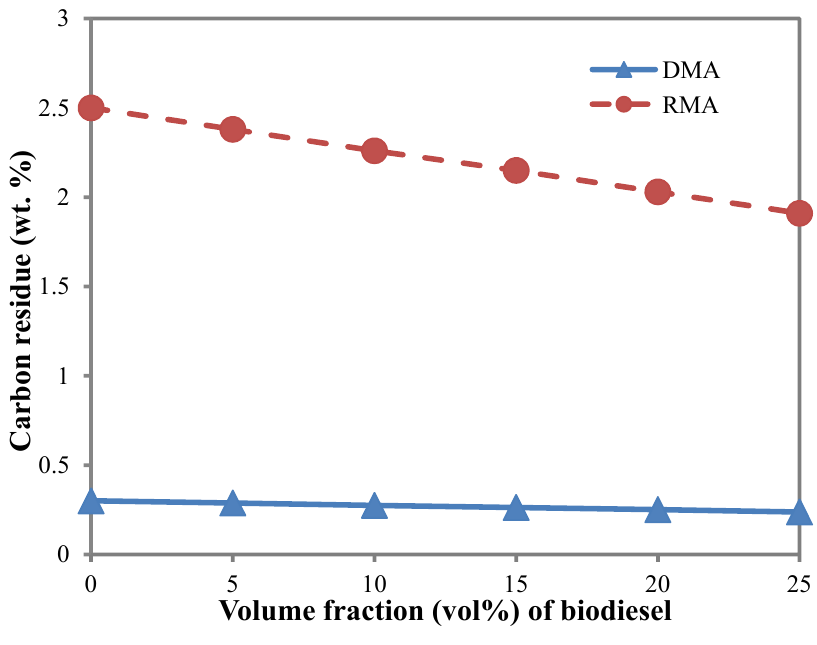
Figure 4. Variation of carbon residue with volume fraction of biodiesel blends in distillate marine fuel DMA and residual marine fuel